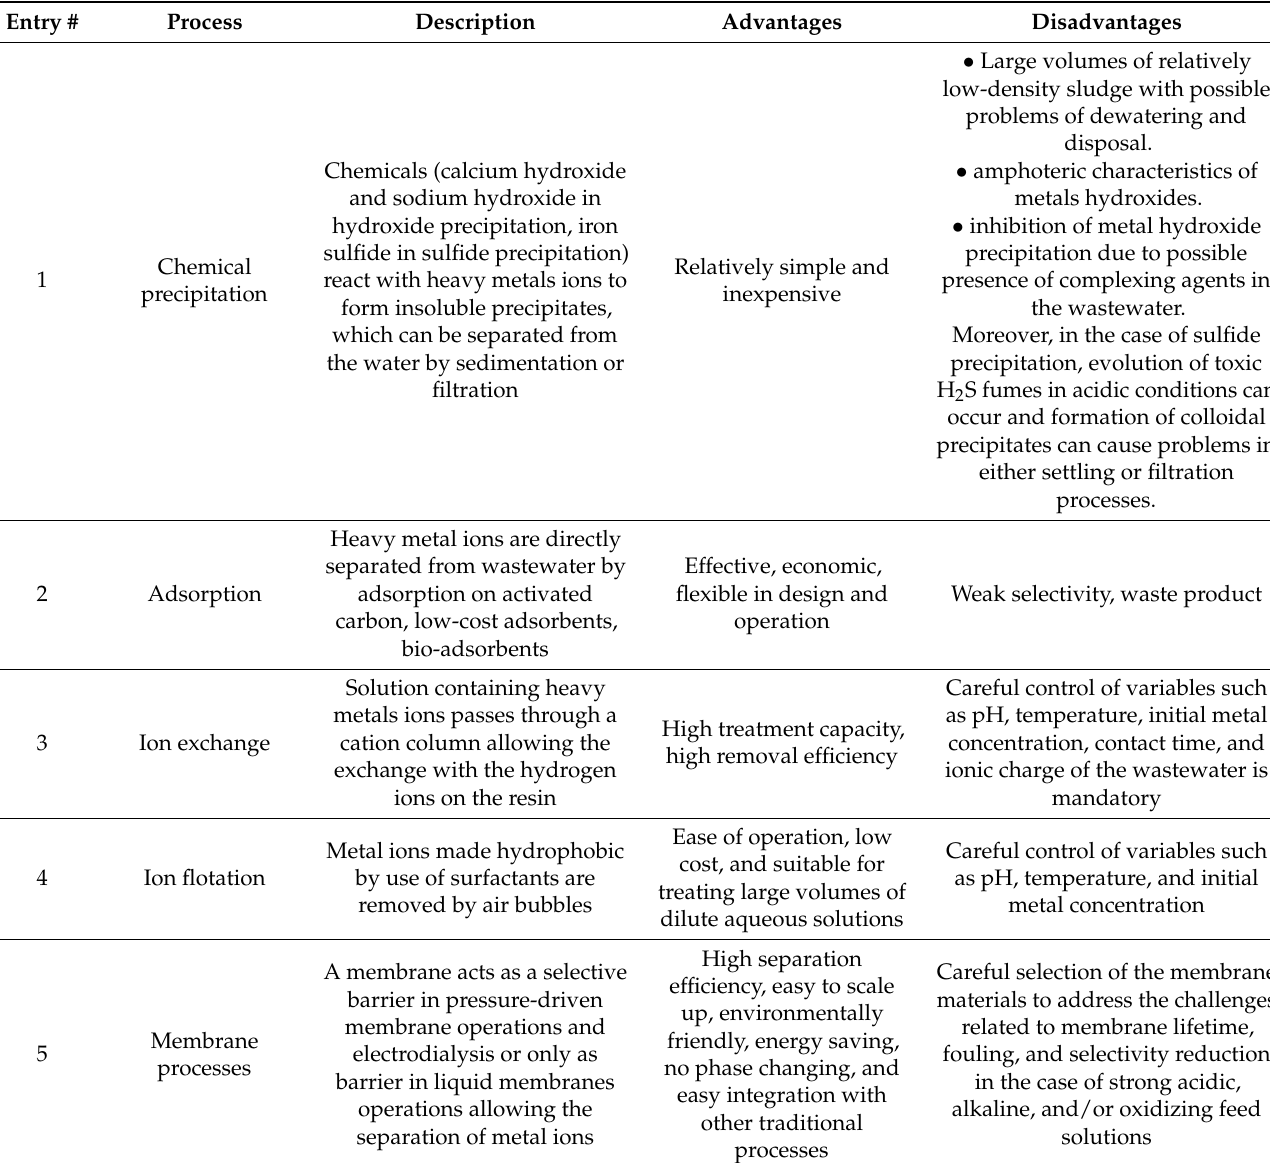
Table 2. Overview of various processes for heavy metal and metalloid